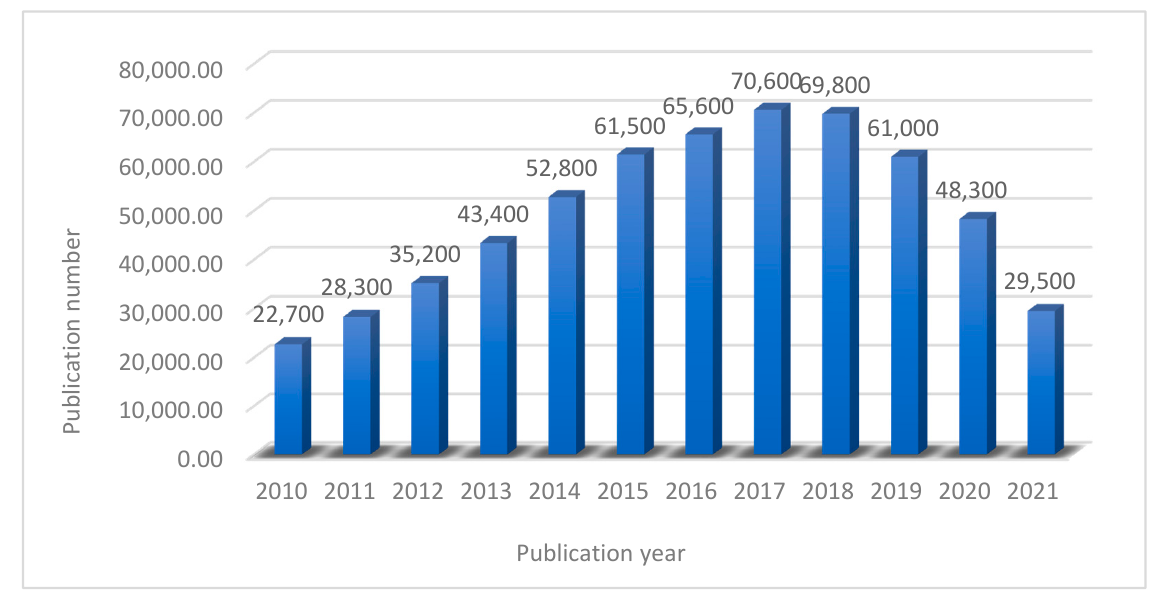
Figure 1. A short post-2010 timeline showing the number of water treatment nanomaterial-based membrane related academic publications.